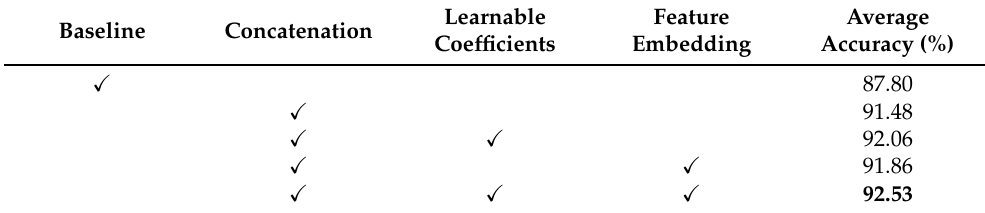
Table 9. The results of different concatenating schemes for hand-crafted features and CNN features.